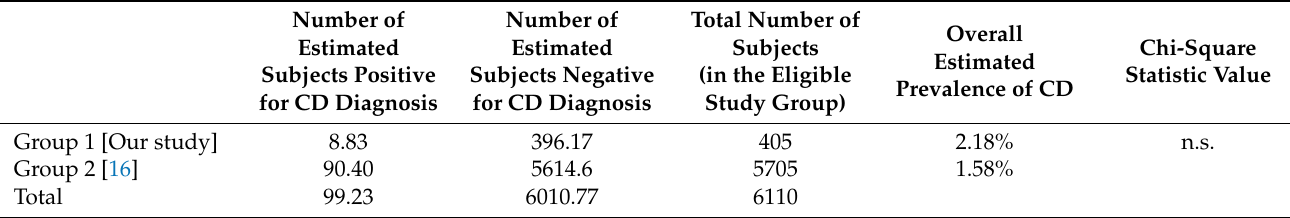
Table 3. Comparison between the estimated prevalence of CD in our sample and in a pediatric Italian sample matched for